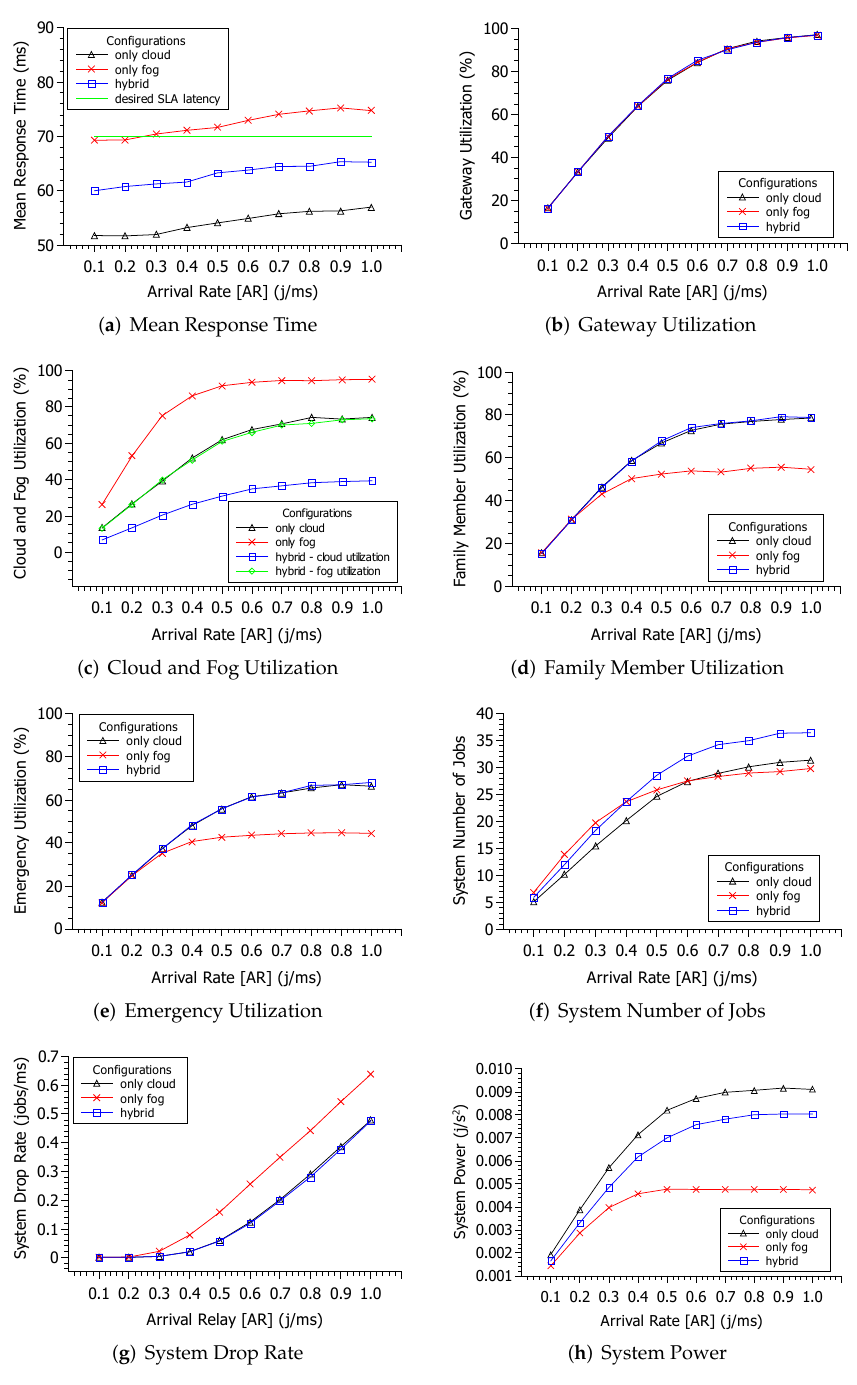
Figure 6. Results changing the arrival rate with distinct load balancing